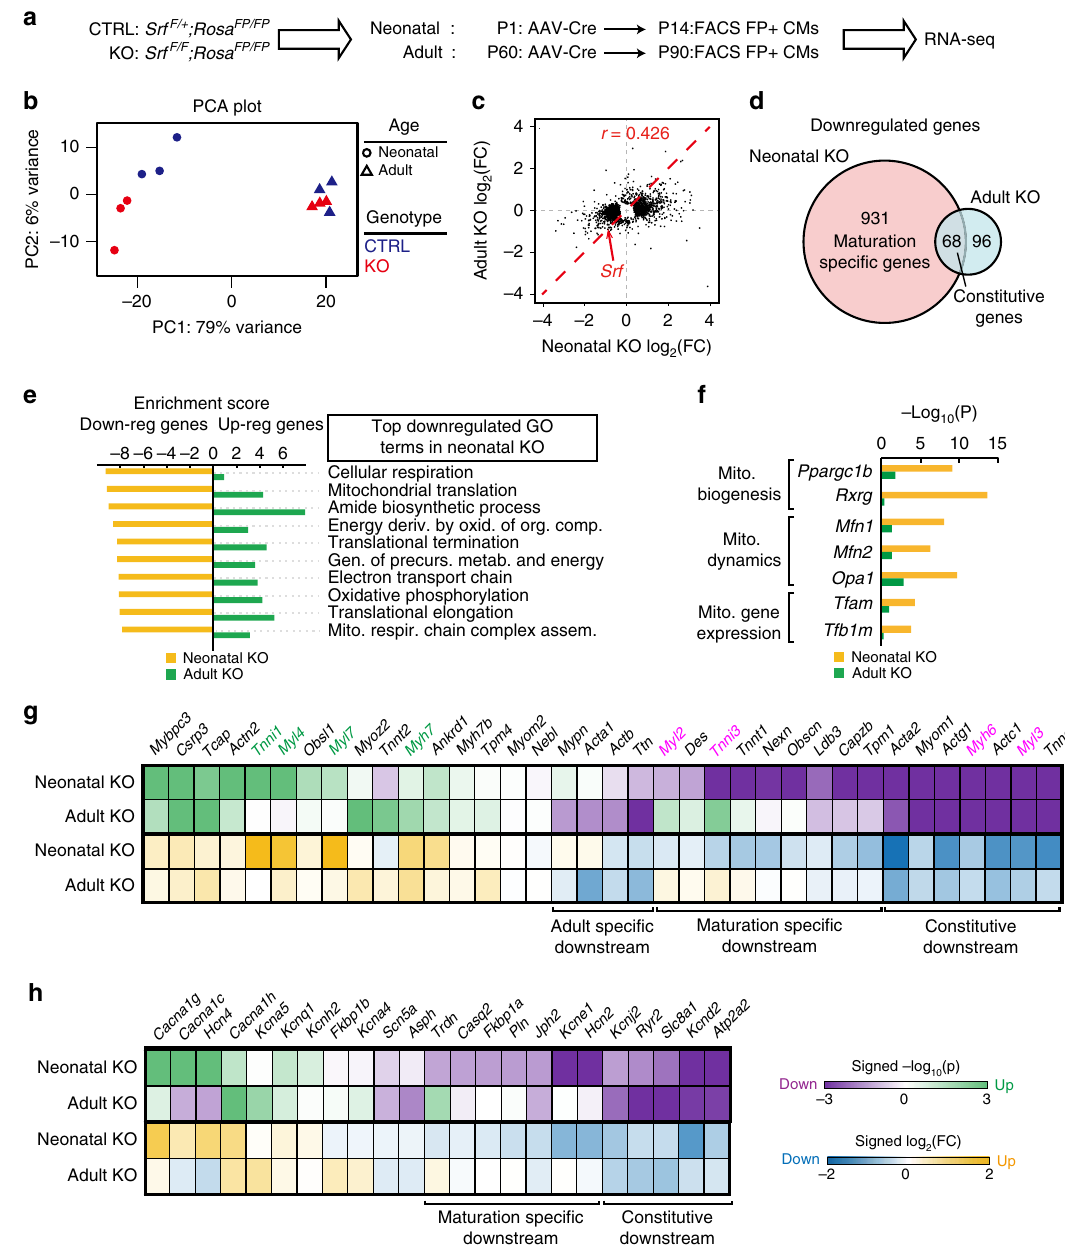
Fig. 3 Maturation-speci fi c transcriptional regulation by SRF. a Experimental design. Mosaic SRF depletion was induced at neonatal or adult stages. Transduced CMs were FACS-puri fi ed and analyzed by RNA-seq. b PCA plot of RNA-seq results (also see Supplementary Fig. 4a). c Comparison of gene expression changes in neonatal or adult Srf ablation. The fold changes (KO/CTRL) of differentially expressed genes ( P value <0.05) in neonatal or adult KO models were plotted. r = Pearson's correlation coef fi cient. Red arrow points to Srf , which was similarly depleted in both models. d Venn diagram of down- regulated genes in neonatal or adult KO. e Gene ontology terms enriched among genes down-regulated in the neonatal KO model. The GSEA 20 normalized enrichment scores for the top 10 terms in the neonatal KO model are shown in yellow, and the corresponding scores of the same terms for the adult KO model are shown in green. Negative and positive scores show down-regulation or up-regulation, respectively. f Representative mitochondrial genes that were selectively down-regulated in neonatal KO but not in adult KO. g , h Differential expression analyses of major sarcomere ( g ) and calcium handling ( h ) genes. Magenta-green and blue-yellow color scales indicate the differential expression P values and fold changes, respectively. Negative and positive values denote down-regulation and up-regulation, respectively. In g , mature (magenta gene names) and immature (green gene names) myo fi brillar isoforms are highlighted. Differential expression P values were calculated by DESeq2 59 with Benjamini – Hochberg